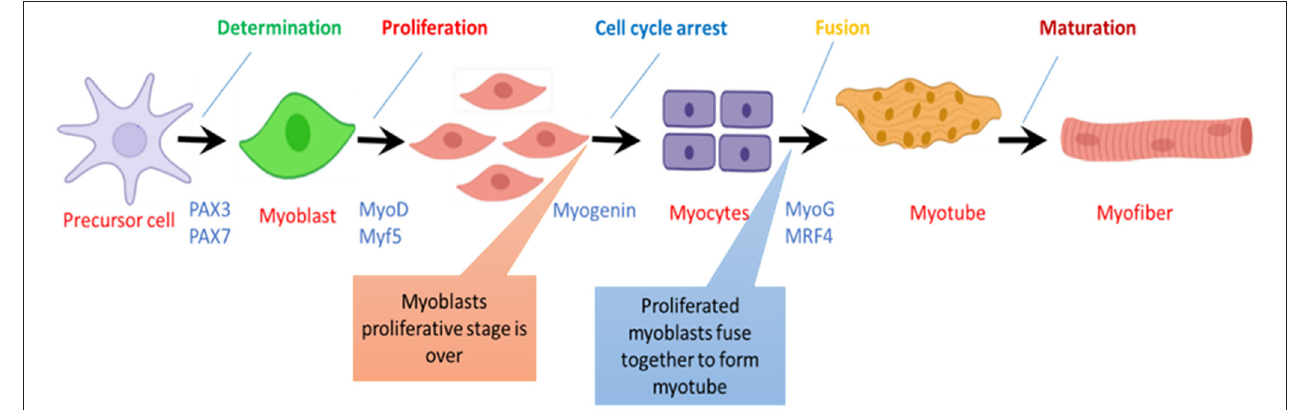
FIGURE 3 | Step wise progress of myofiber formation during skeletal muscle development.in